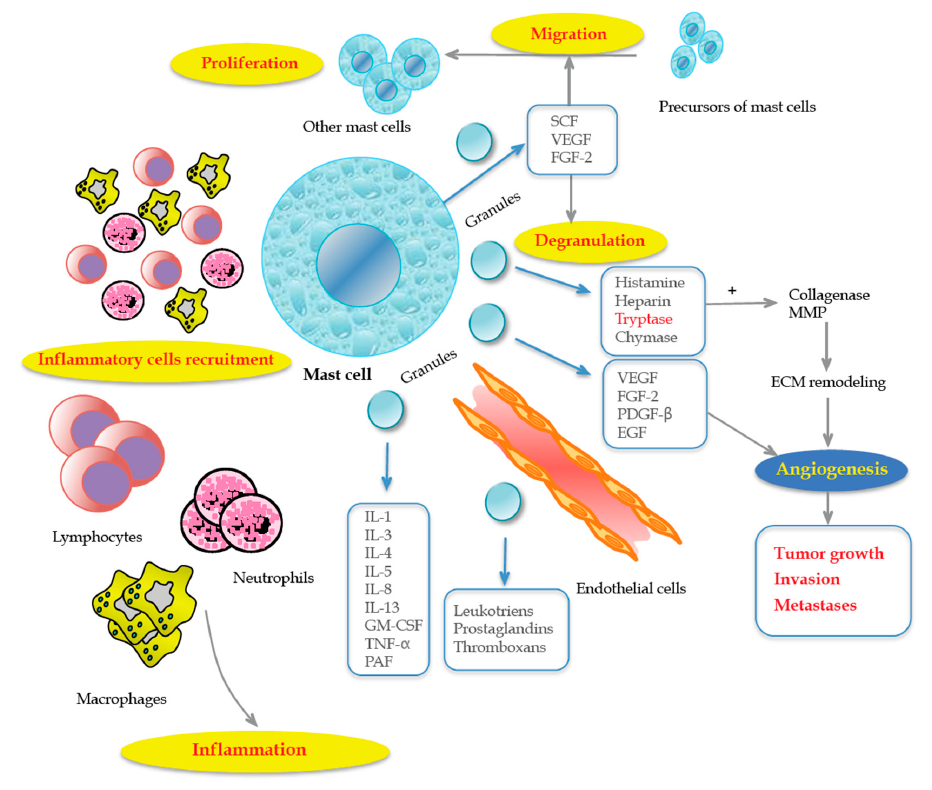
Figure1. Thecloserelationshipbetweenmastcells(MCs)andtumorprogressionangiogenesis-mediated. Figure 1. The close relationship between mast cells (MCs) and tumor progression angiogenesis- mediated. Reproduced with permission from Marech et al. [35]. Reproduced with permission from Marech et al.